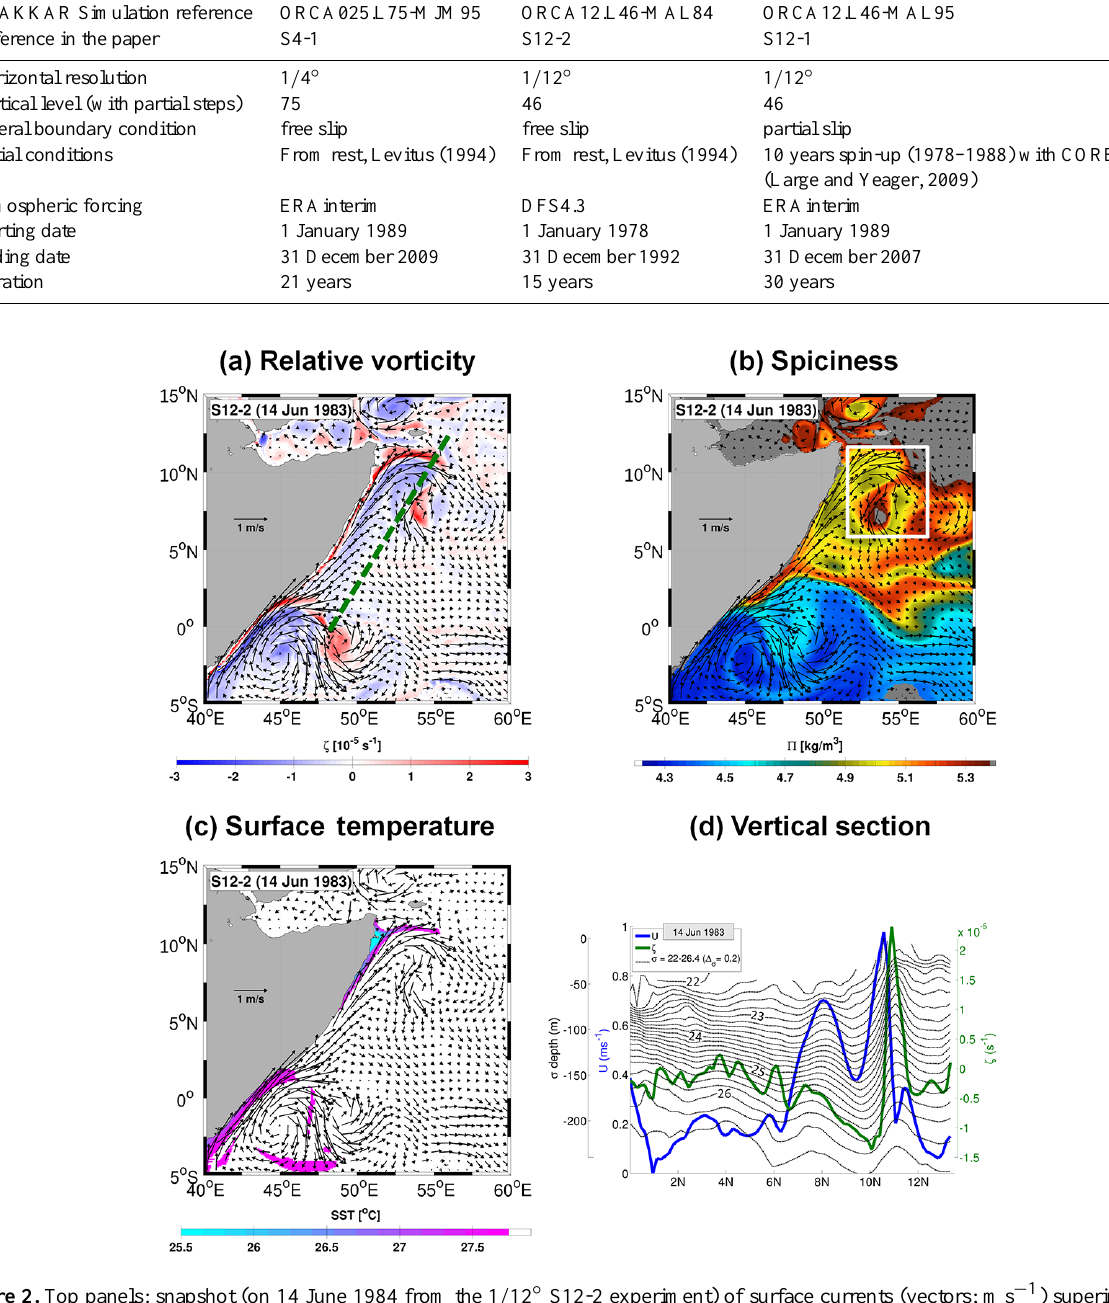
Figure 2. Top panels: snapshot (on 14 June 1984 from the 1 / 12 ◦ S12-2 experiment) of surface currents (vectors; ms − 1 ) superimposed on (a) the relative vorticity ( ζ ; colour shading; s − 1 ) at depth 50m; (b) the spiciness on σ 0 = 23 . 8 ( (cid:53) ; colour shading; kgm − 3 ). The square box (white line) is the GW box which defines the area where statistics of spiciness have been calculated. Bottom panels: (c) snapshot of the sea surface temperature (SST; colour shading; ◦ C); (d) this panel shows along an oblique section parallel to the coast (and passing through the Somali eddies as shown on the relative vorticity panel): the depths of the isopycnals comprised in the range 22 ≤ σ 0 ≤ 26.4 (black contours by interval of 0.2), the variation of relative vorticity ζ at 50m depth (green line), and the variation of the current speed U at depth 50m (blue